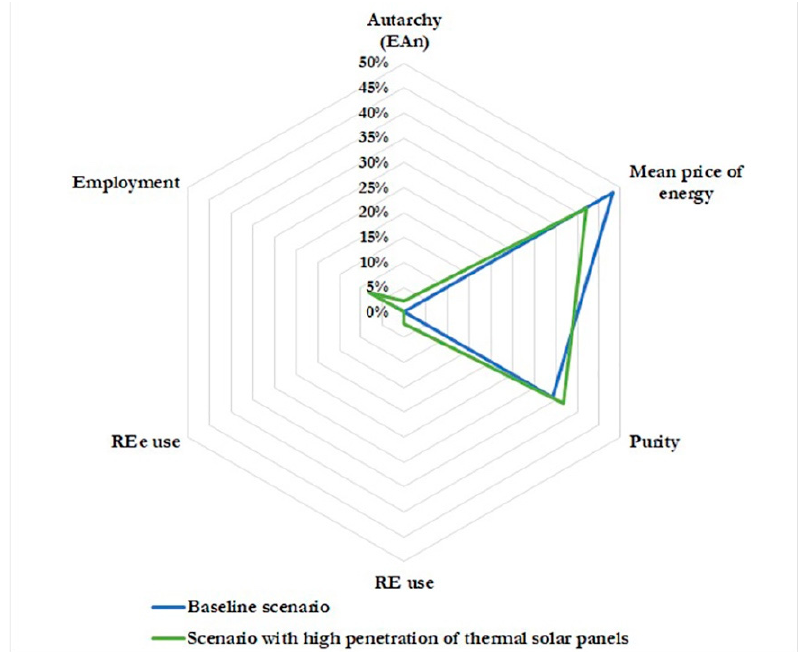
Figure 12. Behavior of the indicators regarding the use of ST energy for DHW in the city of Cuenca.